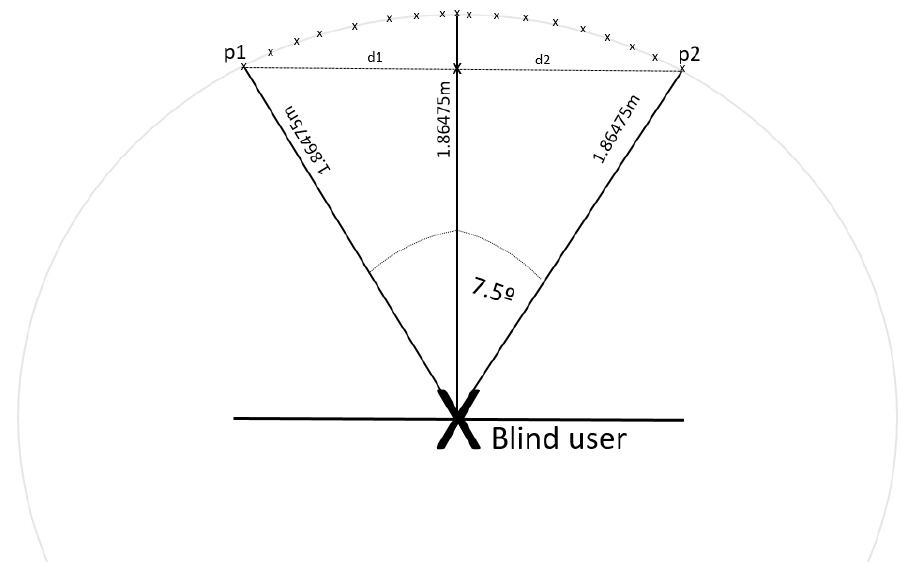
Figure 7. Different frontal positions of the obstacle.